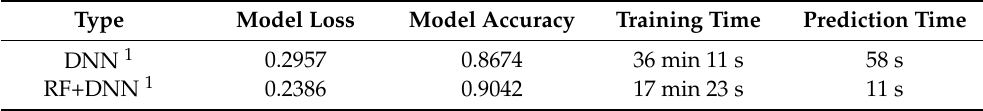
Table 4. Comparison of DNN and RF+DNN classification